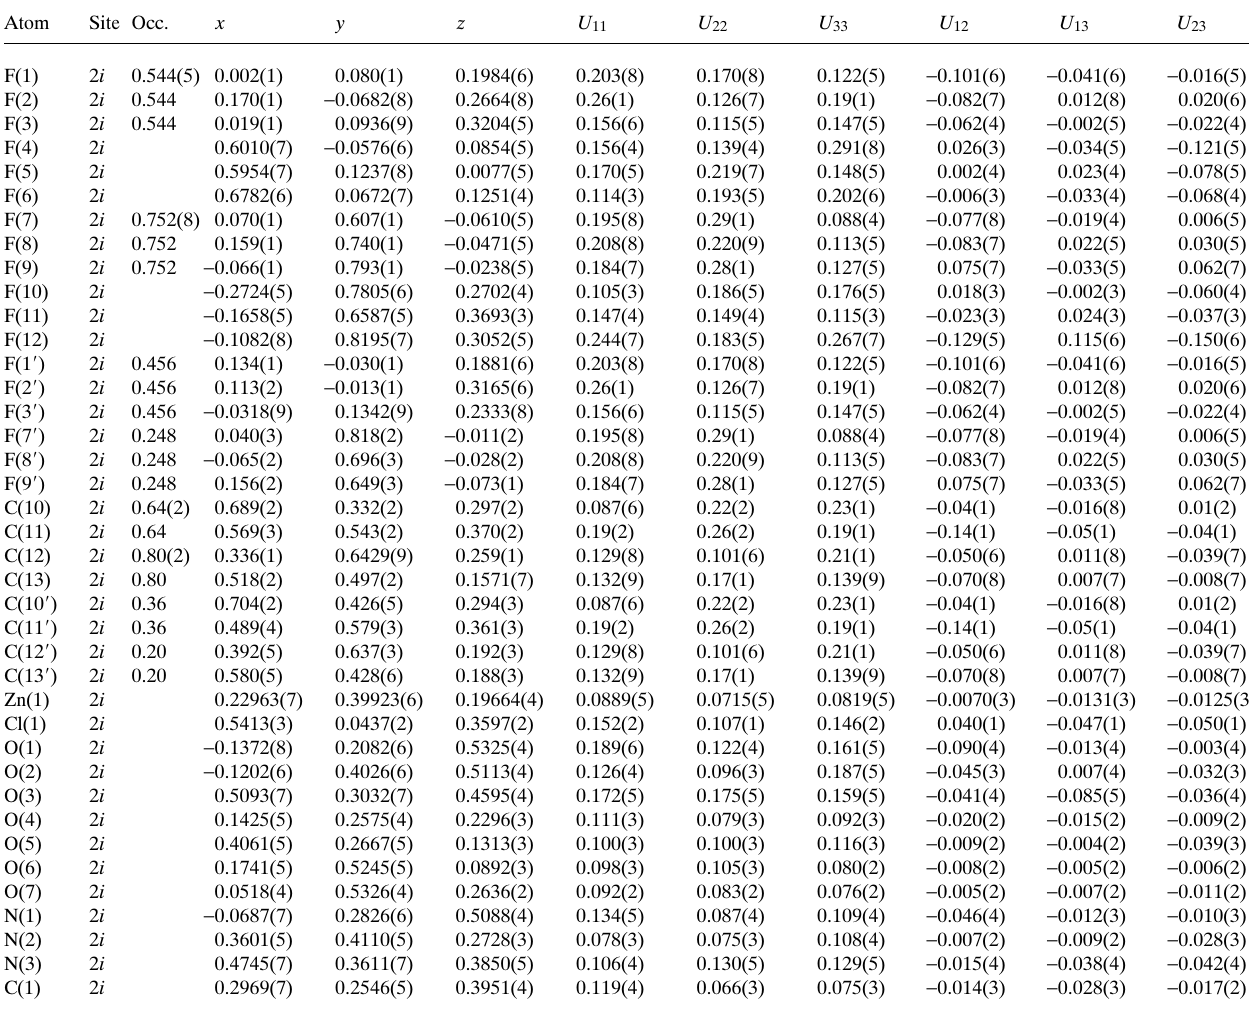
Table 3. Atomic coordinates and displacement parameters (in Å 2 ) .